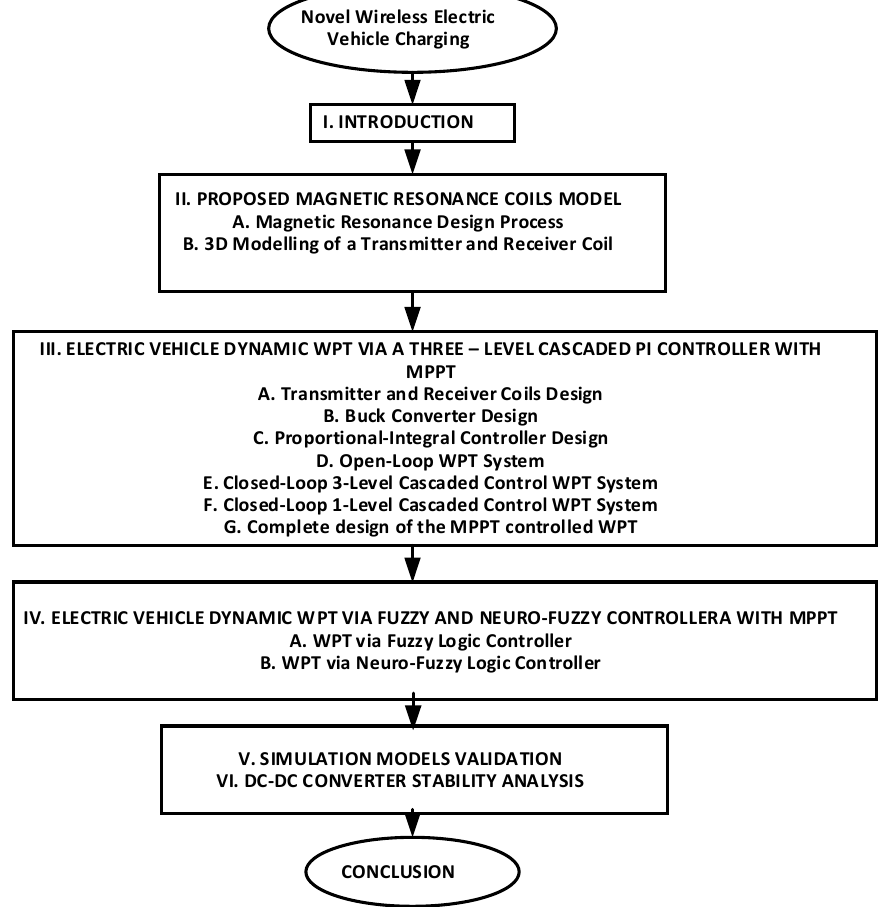
Figure 1. Overall flowchart of procedures.